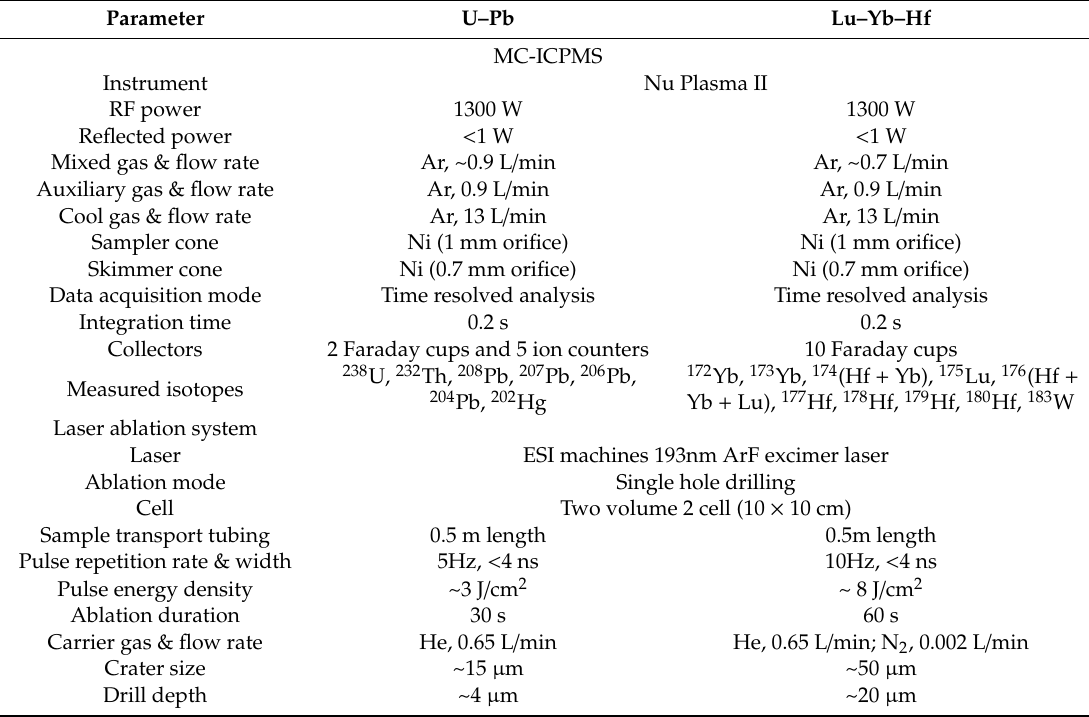
Table 1. LA-MC-ICPMS instrument and operational parameters for U–Pb dating and Lu–Yb–Hf isotope